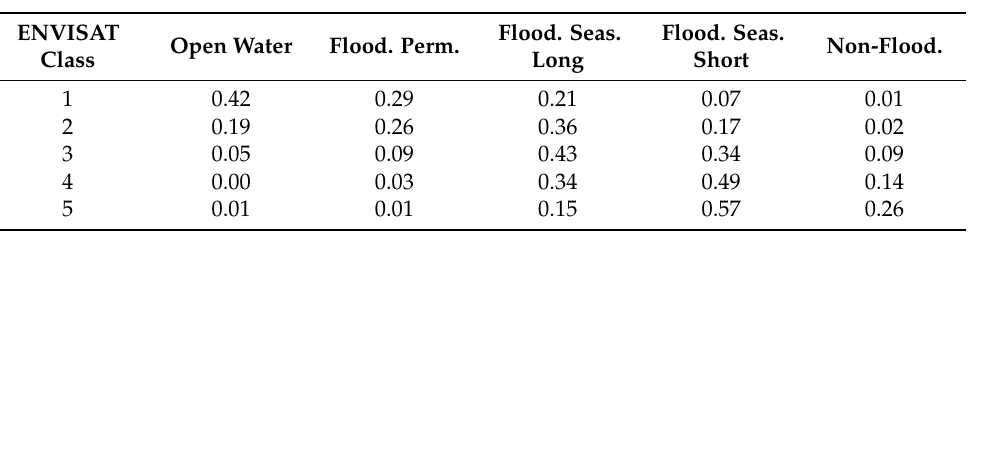
Table A4 (4 classes) and Table 2 (5 classes) for Jason-2. Table 1. Confusion matrix between 5 classes of RA backscattering coefficients from ENVISAT and the 5 land type classes identified on the study